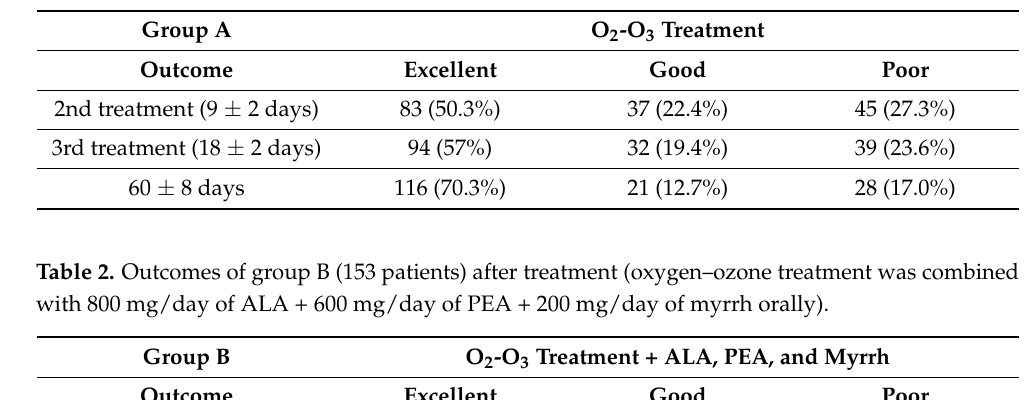
Table 1. Outcomes of group A (165 patients) after treatment (ozone-depleting pain relief therapy under CT scan with intraforaminal technique). Group A O 2 -O 3 Treatment Outcome Excellent Good Poor 2nd treatment (9 ± 2 days)